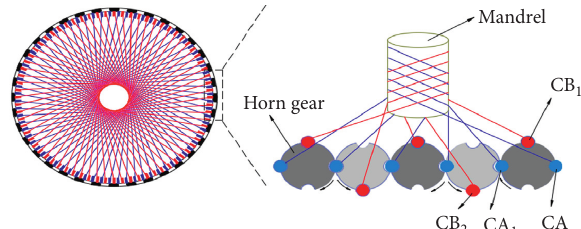
Figure 2: Diagram of the braiding process.